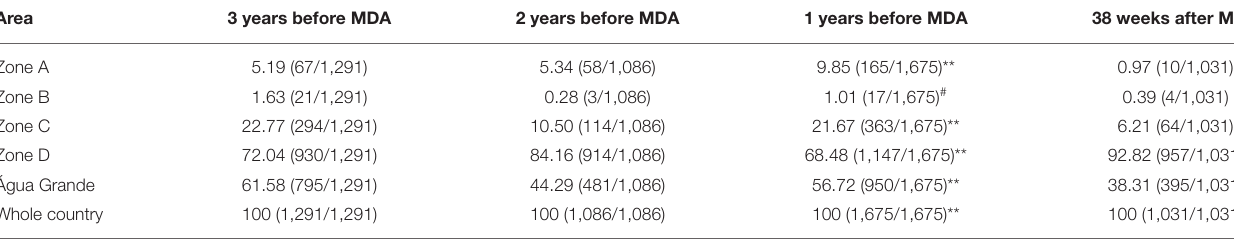
TABLE 4 | Proportion of cumulative malaria cases (%) * (cases of each zone/ total cases) pre- and